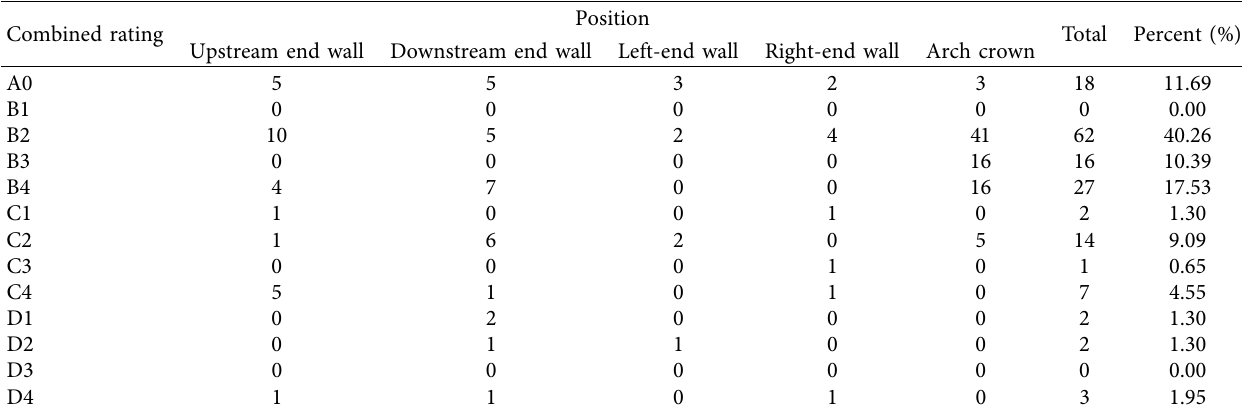
Table 11: Combined ratings of anchor heads structure.